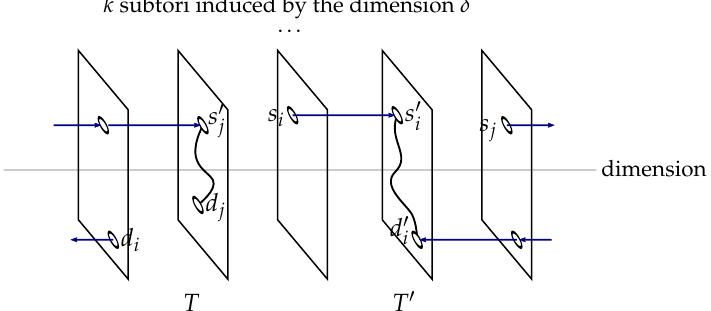
Figure 7. Disjointly connecting one source-destination pair inside subtorus T (cid:48) and the other pairs inside subtorus T [9].